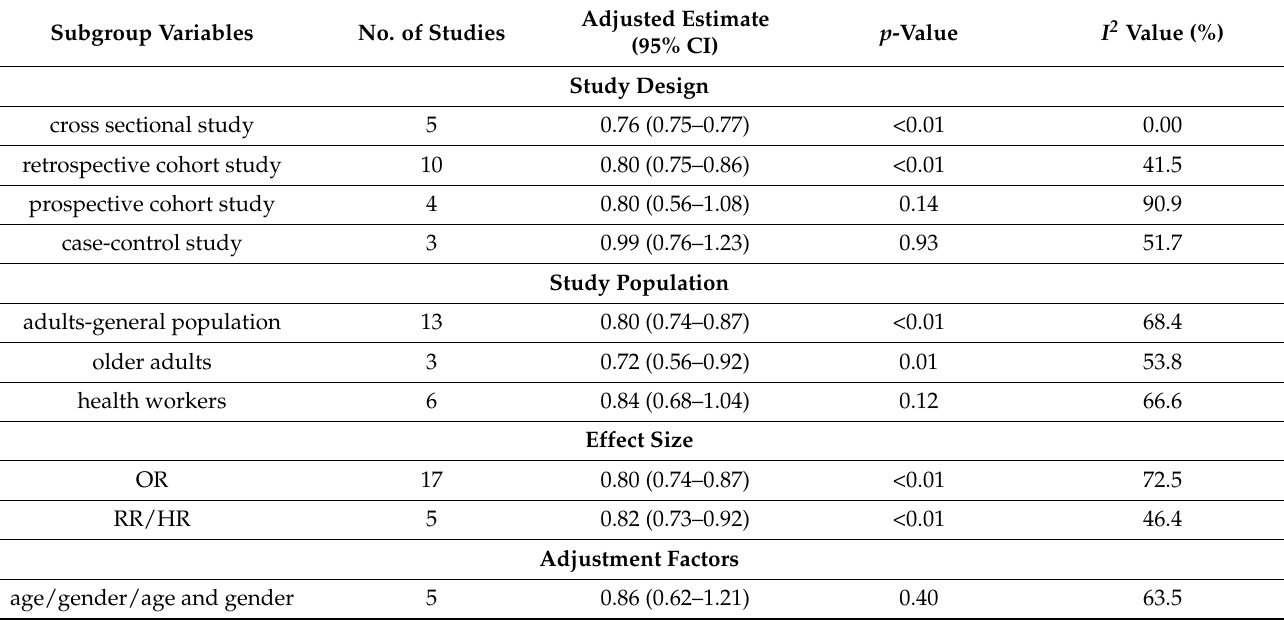
Table 5. Subgroup analysis of the association between influenza vaccination and SARS-CoV-2 in- fection.